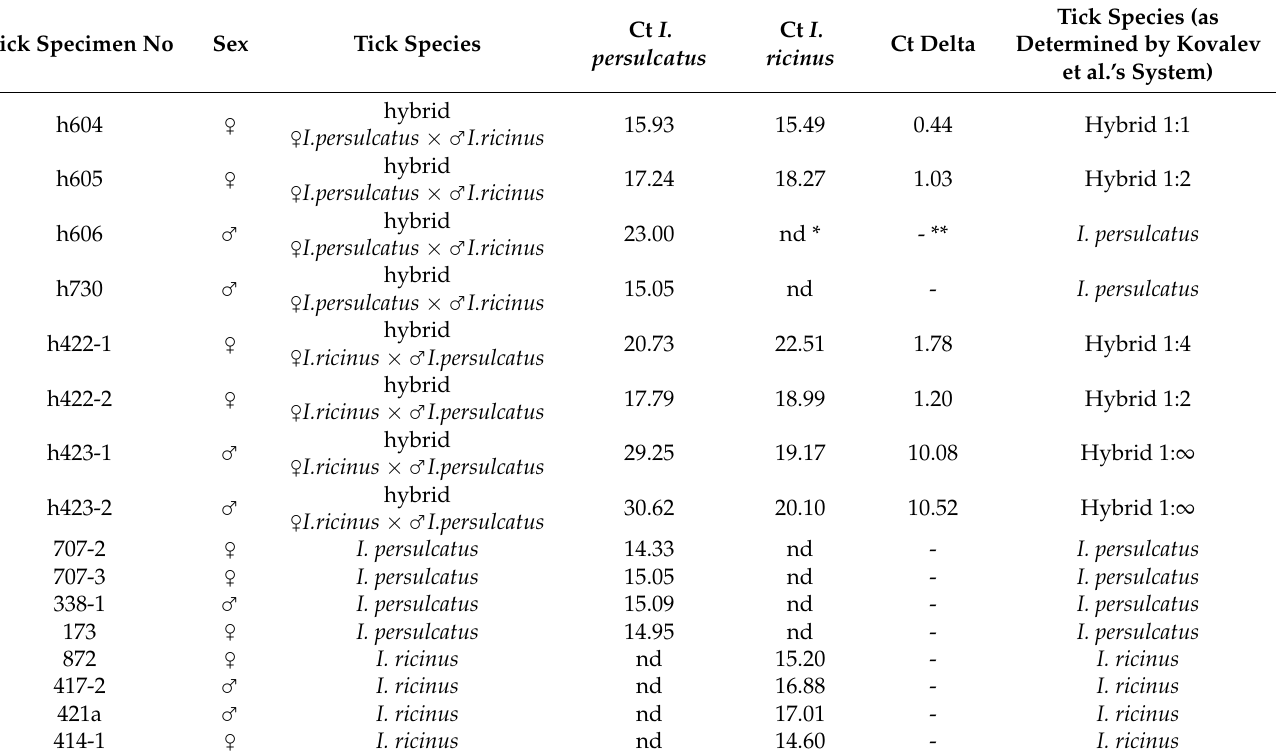
Table 3. Results of the hybrid differentiation using method previously described by Kovalev et al. [17].